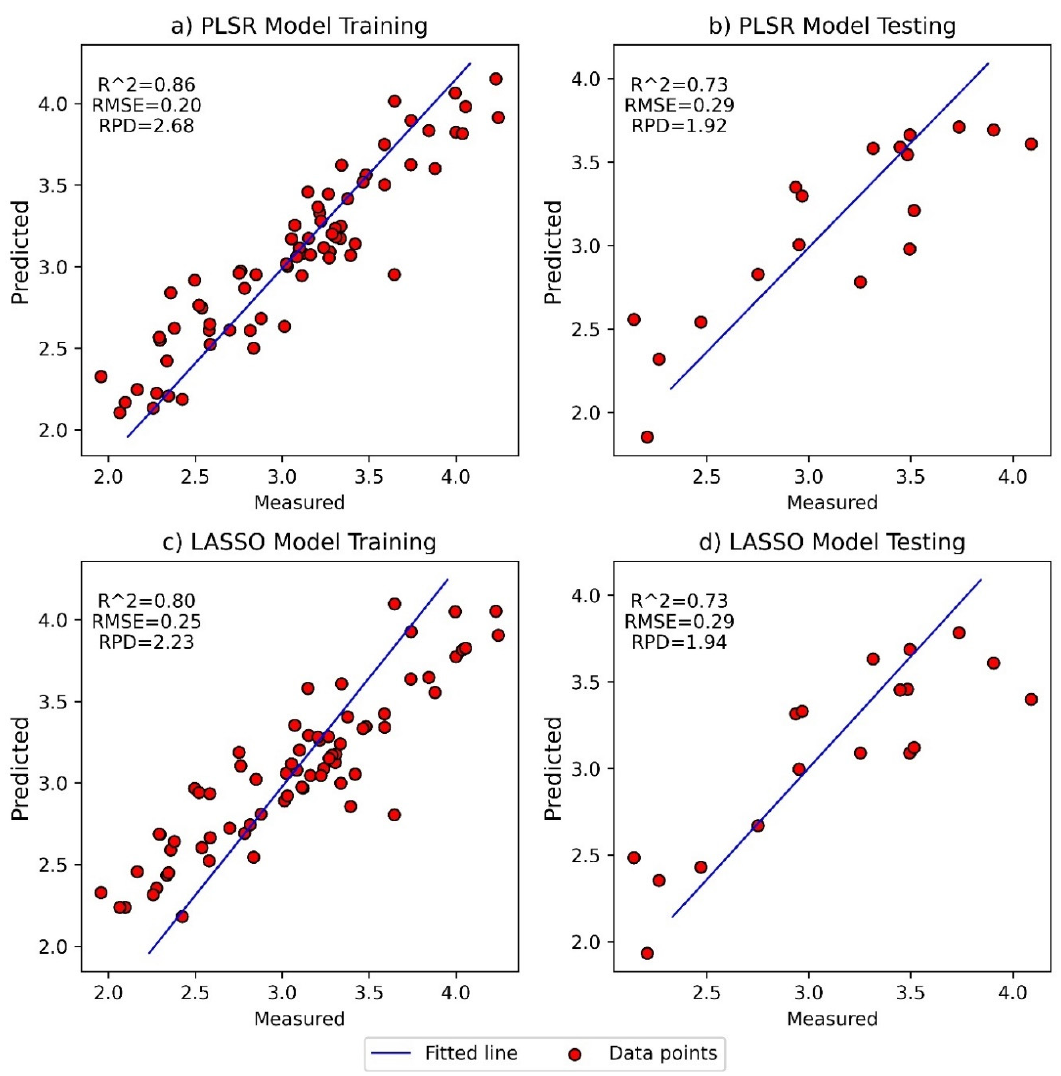
Figure 5. Measured vs. predicted ratio of 6-gingerol to 6-shogaol for the training and test datasets for best fit model from PLSR ( a , b ) and LASSO ( c , d ) regressions. These two models showed acceptable performance after optimum wavelength selec- tion (Figure 7), but their accuracy was lower compared to other models which did not apply optimum wavelength selection (shown in Figure 5). The calculated limits of detec- tion for the VIP and β -coefficient models were gingerol-to-shogaol ratios of 0.8 and 1.0, respectively. These were moderately higher compared to the LODs found for the regular PLSR and LASSO models.